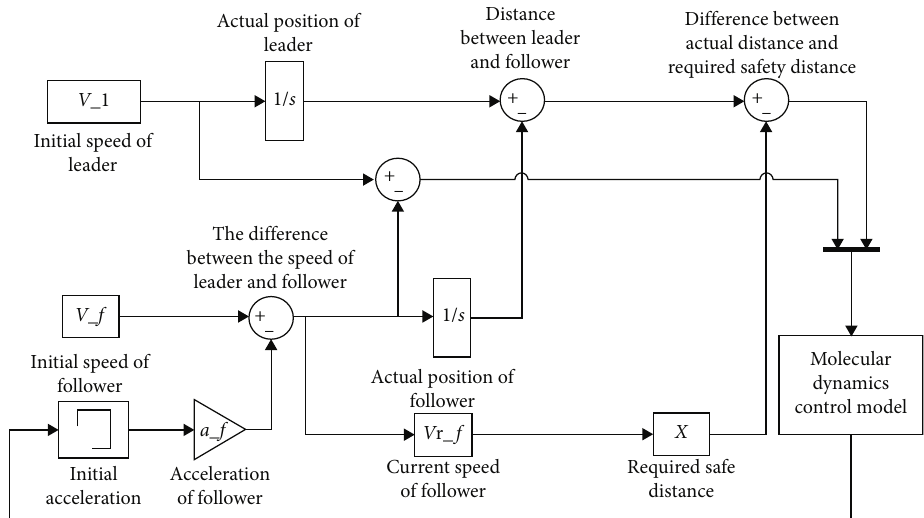
Figure 8: Block diagram of the simulation process.